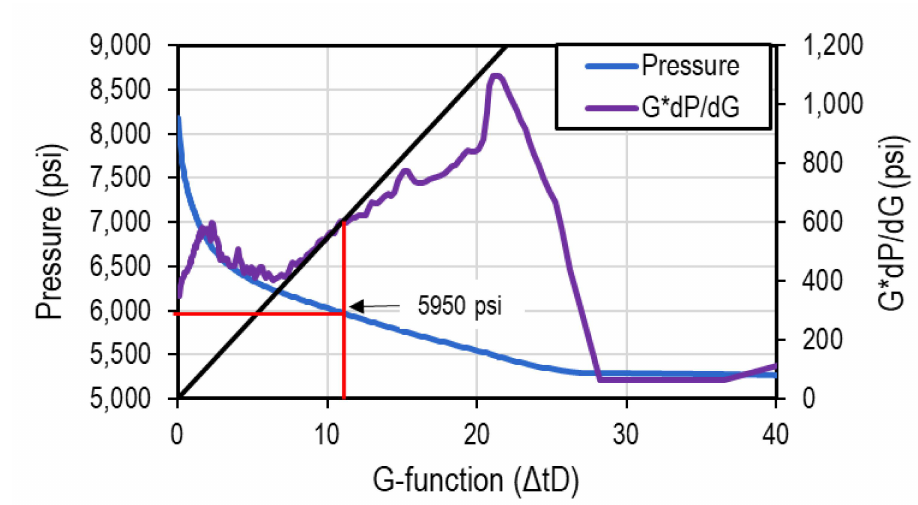
Figure 10. DFIT analysis using tangent method Well #1 (Woodford Formation).